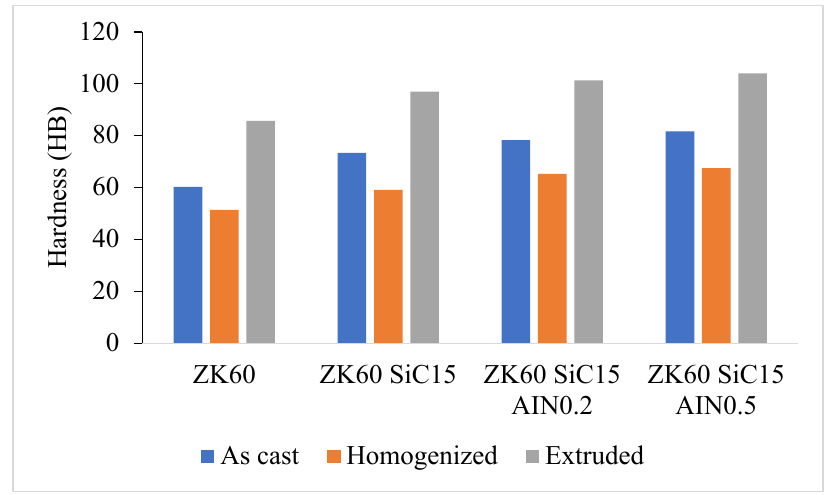
Figure 9. Comparison of the hardness test results for as cast, homogenized, and extruded samples.